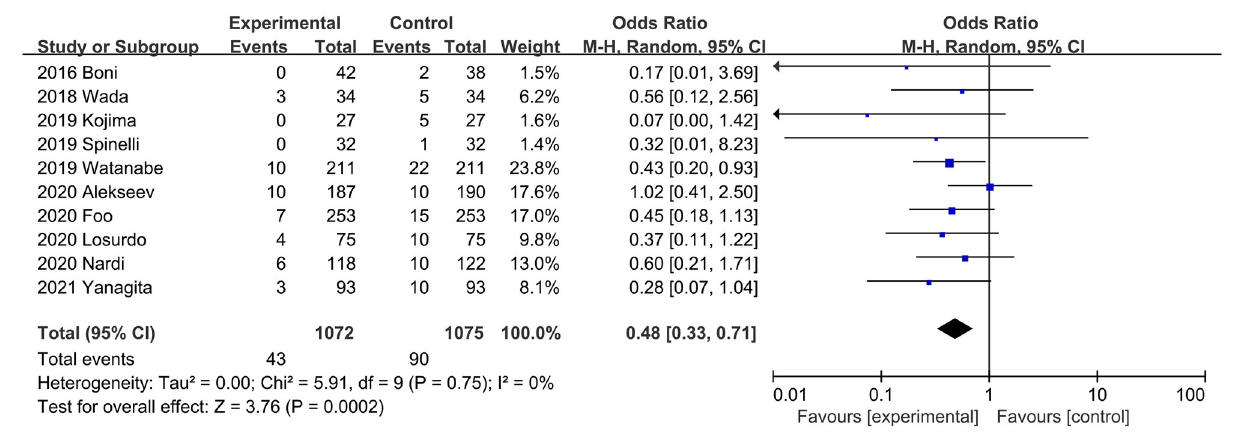
FIGURE 4 | Effect of indocyanine green on symptomatic anastomotic leakage rate.